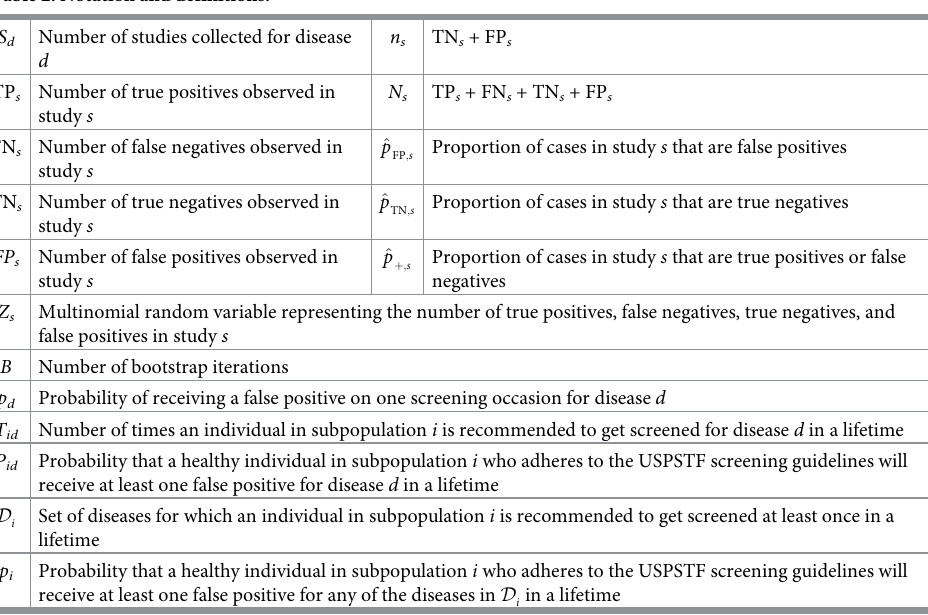
Table 2. Notation and definitions.